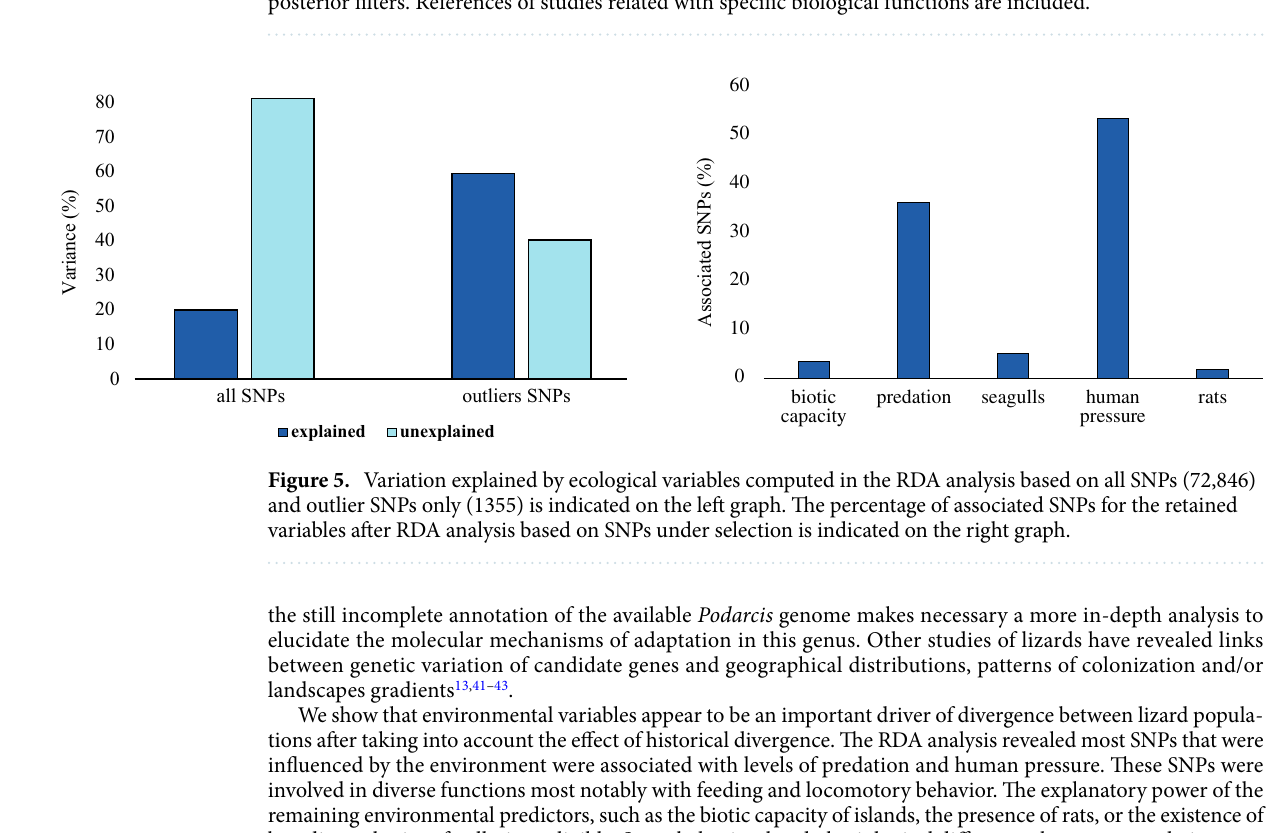
Table 1. Gene ID, definition, Kegg pathway, GO-molecular function and GO-biological process found in Podarcis or Anolis annotated genomes of the 1,355 outliers SNPs obtained by BayeScan analysis and the posterior filters. References of studies related with specific biological functions are included.